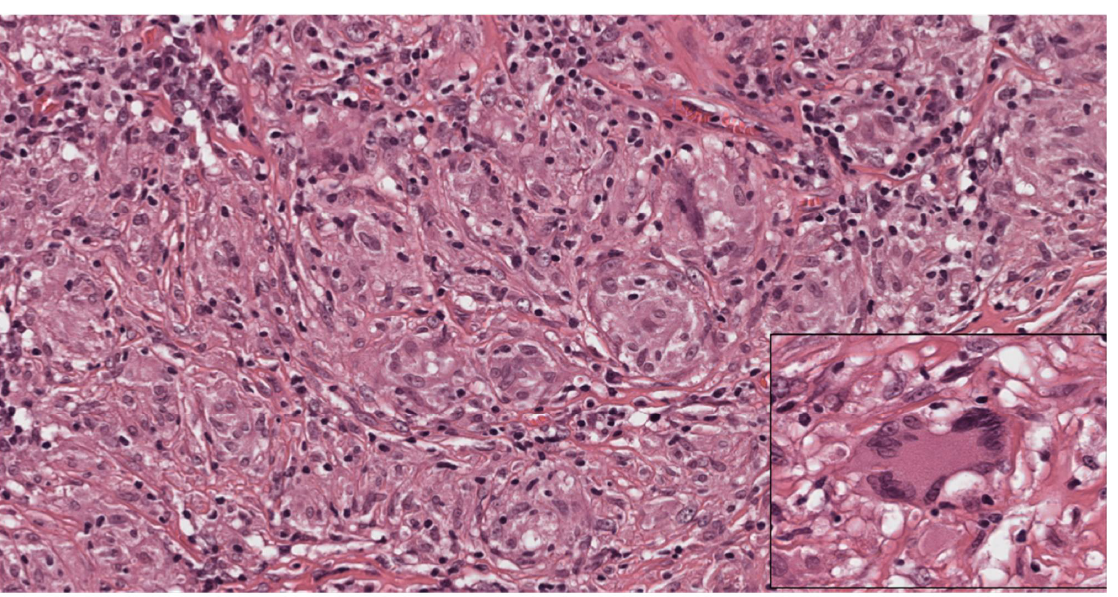
Figure 3. Cytological aspects of sarcoidosis. The granulomas are composed mostly of epithelioid histiocytes with sparse intermingled mature lymphocytes. The histiocytes show oval nuclei and abundant eosinophilic cytoplasm. Occasional giant cells (inset) can be observed. (Haematoxylin and eosin, 300×; inset: 400×).